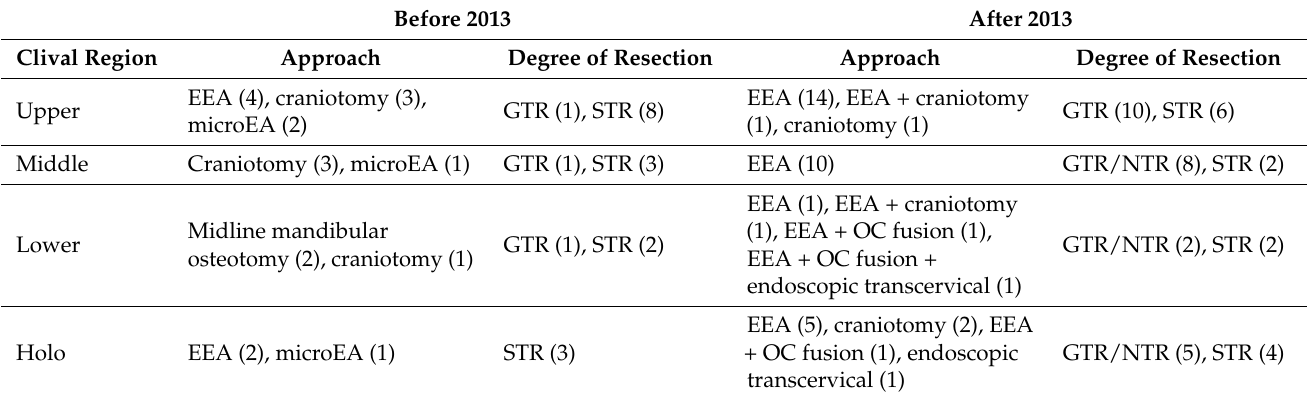
Table 2. The operative approach and the degree of resection based on the clival chordoma location.